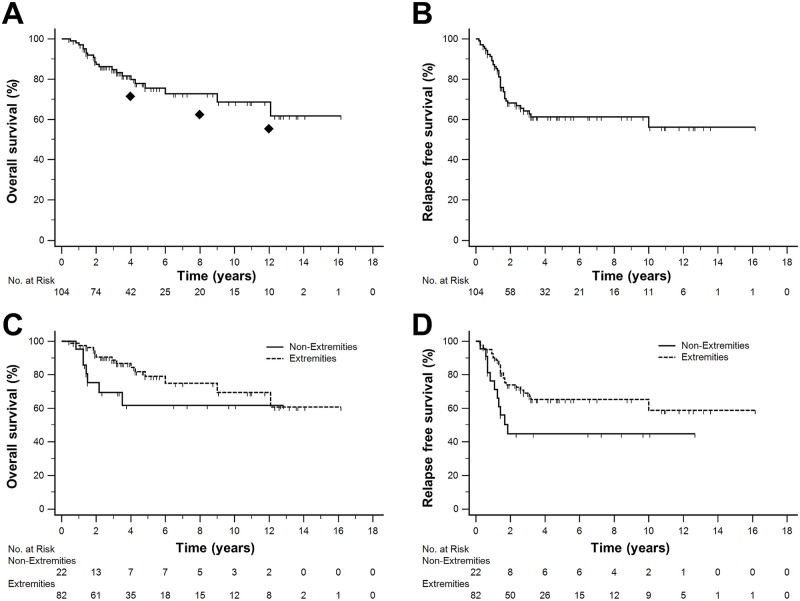
Kaplan-Meier estimates of recurrence free survival (RFS) and overall survival (OS).(A) OS in the entire cohort (n = 104) at 2 years was 87.3% (95% CI, 80.5–94.1%) and 75.6% (95% CI, 65.2–86.0%) at 5 years; ◆ indicates calculated survival probability according to MSKCC nomogram at 4, 8, and 12 years. (B) RFS in the entire cohort at 2 and 5 years was 68.1% (95% CI, 58.5–77.7%) and 61.2% (95% CI, 50.4–71.6%) (C) OS stratified by tumor localization (extremities only cohort 90.5% (95% CI, 83.7–97.3%) and 79.0% (95% CI, 68.4–89.6%) at 2 and 5 years. (D) RFS stratified by tumor localization (extremities only cohort was 74.0% (95% CI, 64.0–84.0%) and 65.3% (95% CI, 53.7–76.9%) at 2 and 5 years.